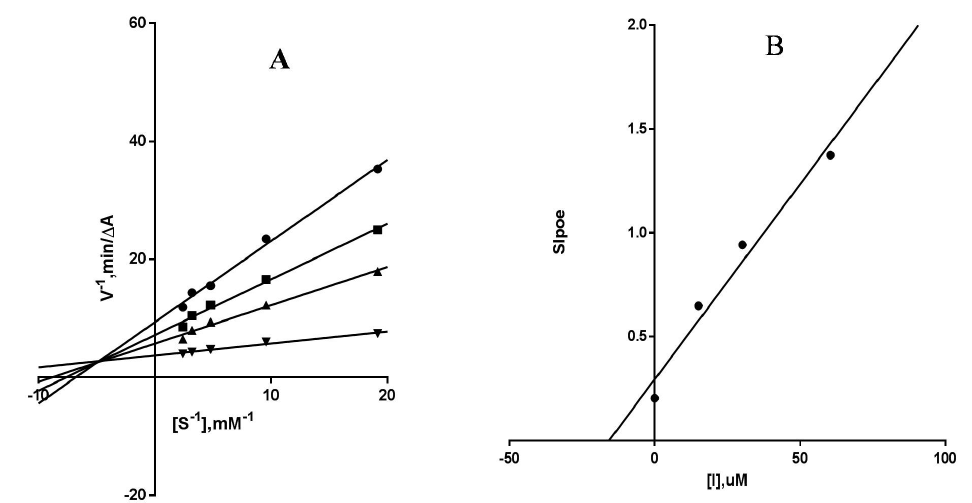
Figure 1. Steady-state inhibition of Eg5 by C9 . ( A ) Lineweaver–Burk plot of reciprocal of initial velocities versus reciprocal of five fixed ATP concentrations (0.417 mM, 0.313 mM, 0.209 mM, 0.104 mM and 0.052 mM) in the absence ( ▼ ) and presence of C9 at 15.13 μM ( ▲ ), 30.25 μM ( ■ ), 60.50 μM ( • ). Lines represent a curve fit of the global data set to a mixed-type inhibition model. ( B ) Secondary plots of the Lineweaver–Burk plot, slope versus various concentration of C9 , with Ki = 15.73 µ